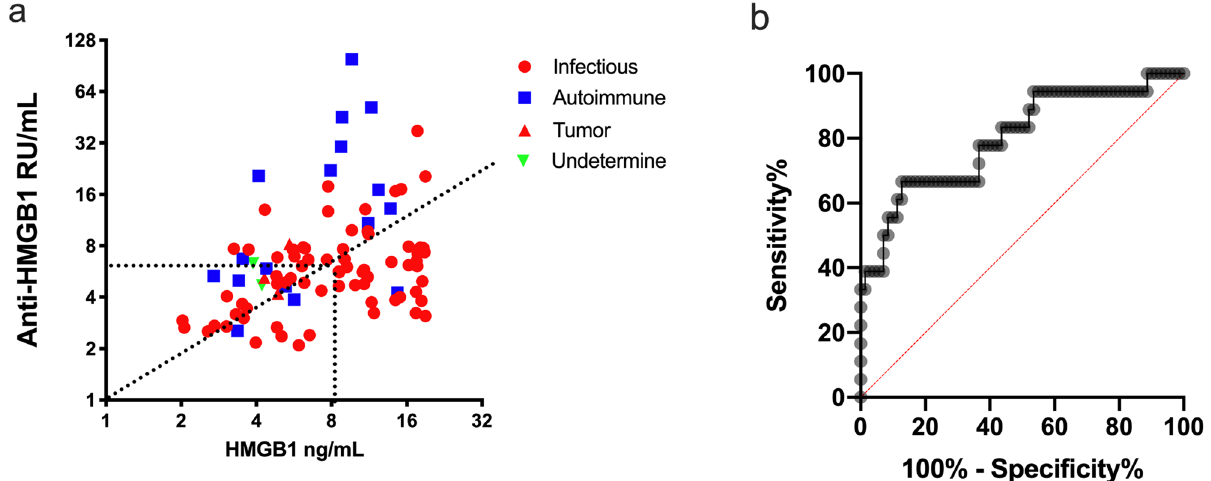
Figure 2. The ratio of serum HMGB1/anti-HMGB1 antibodies in patients with FUO. ( a ) The distribution of the concentrations of serum HMGB1 and anti-HMGB1 antibodies in different subtypes of patients with FUO; ( b ) ROC curve of the ratio of serum HMGB1/anti-HMGB1 antibodies in diagnosis infectious and autoimmune disease subtypes in patients with FUO.